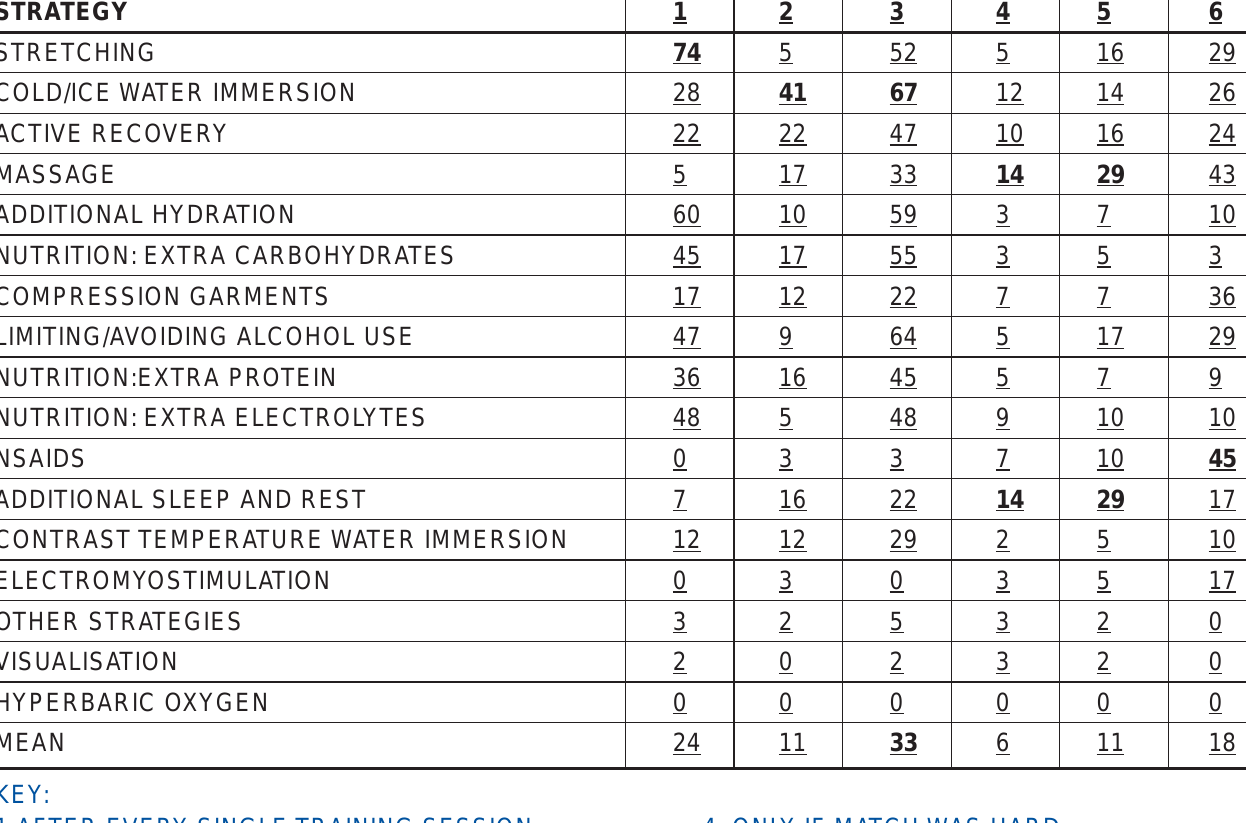
Table 1. Various training and match situations and their association with recovery strategies. The values represent a percentage of the number of respondents (n=58).